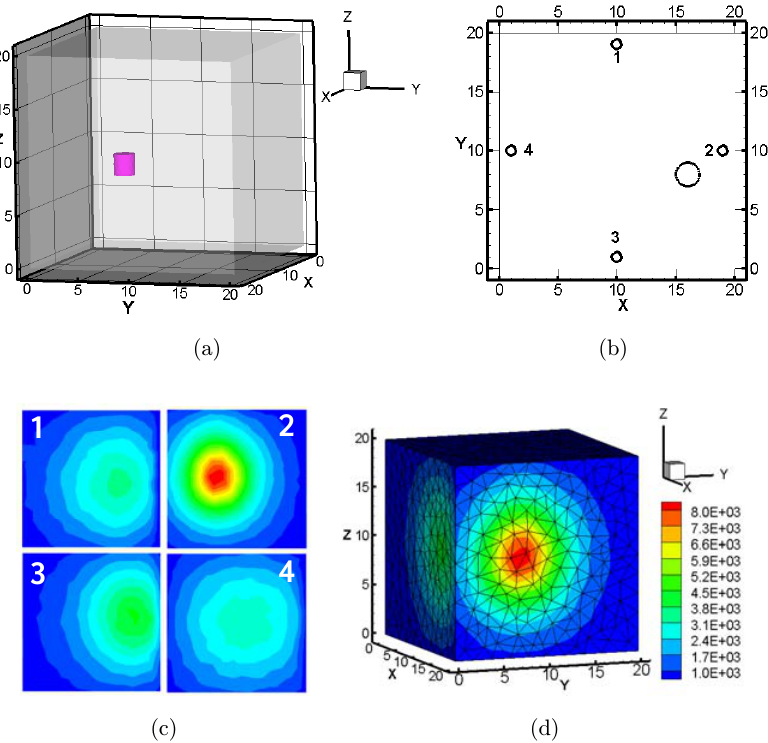
Fig. 6. (a) The 3D view of the single °uorescent target in the cubic phantom. (b) The x – y view on the z ¼ 10 mm plane, where the white dots represent the excitation point source positions. (c) The surface data acquired by CCD at four di®erent views. (d) Inverse mesh and photon distribution on the